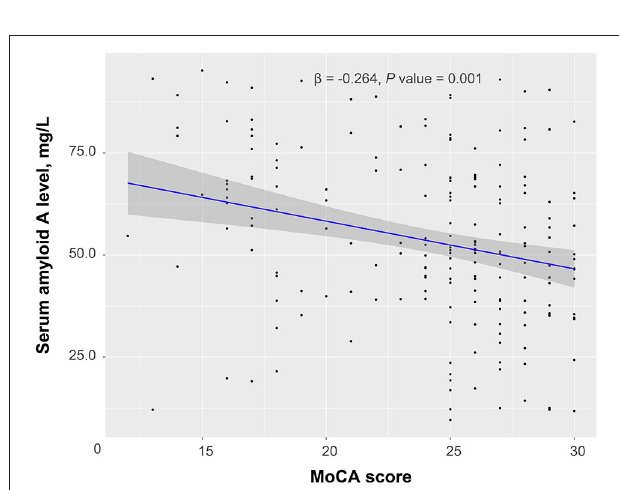
FIGURE 3 | Linear regression analysis confirmed a significant negative association between serum amyloid A levels and a Montreal Cognitive Assessment (MoCA)